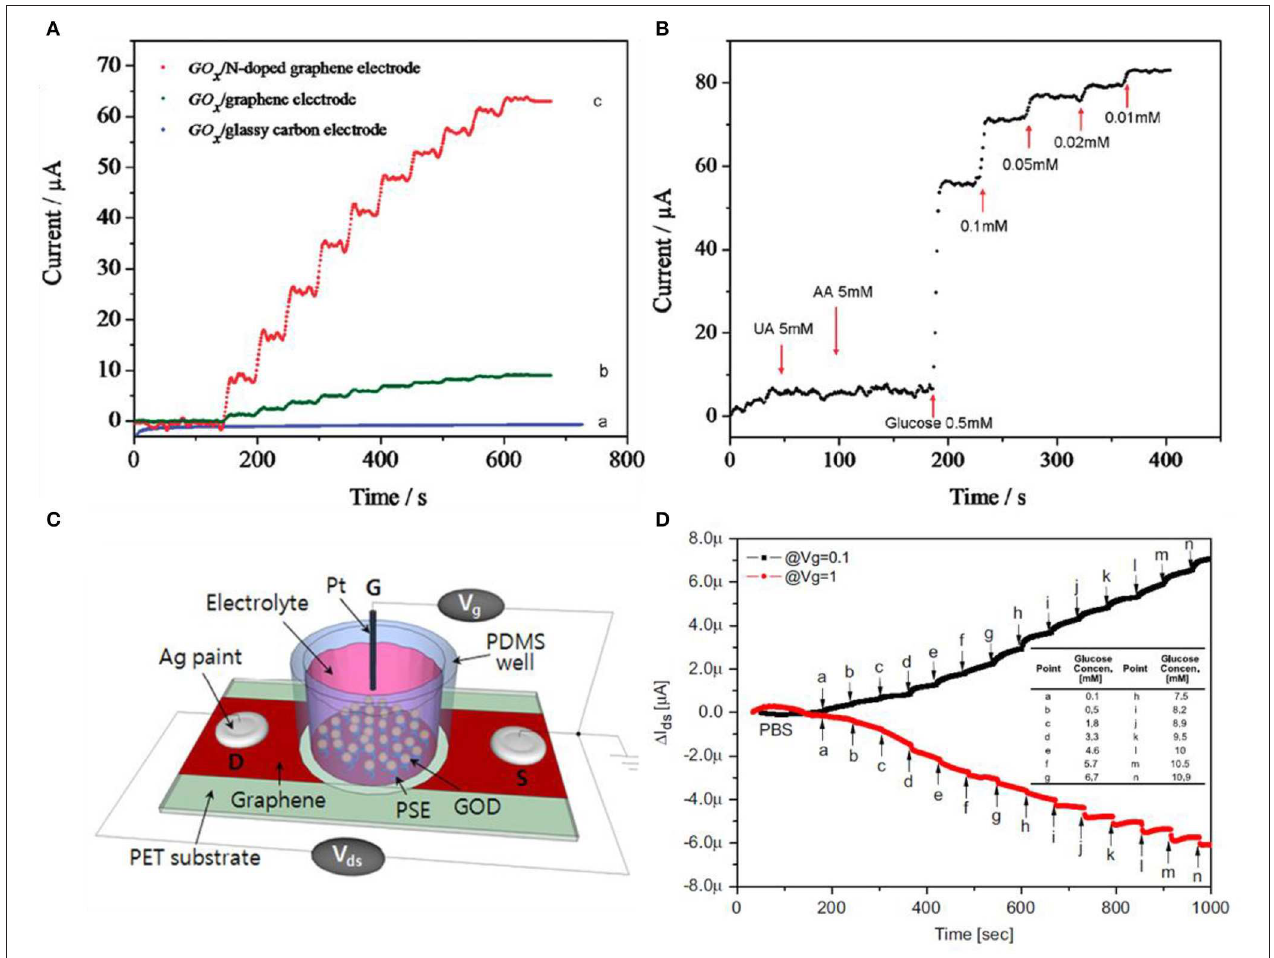
FIGURE 5 | Glucose sensors using graphene-based materials. (A) Glucose responses to various graphene-based materials. (B) N-doped graphene having selectivity to glucose than uric acid and ascorbic acid. Figures (A,B) were reproduced from Wang et al. (2010) with permission from the American Chemical Society. (C) Schematic illustrations of the CVD graphene FET sensor. (D) Response curves of glucose in different gate voltages. Source–drain voltages are fixed to V DS = − 0.2V. Figures (C,D) were reproduced from Kwak et al. (2012) with permission from